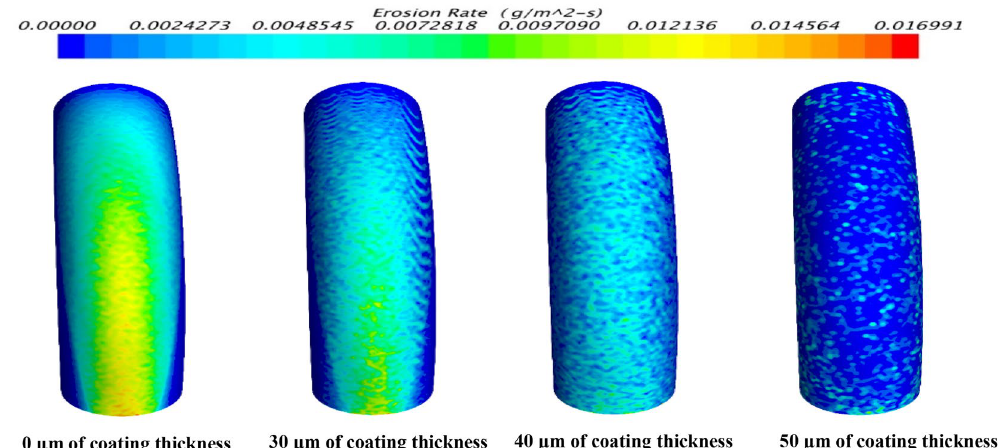
Figure 18. The distributions of the erosion rate profile for the elbow with different values of coating thickness.